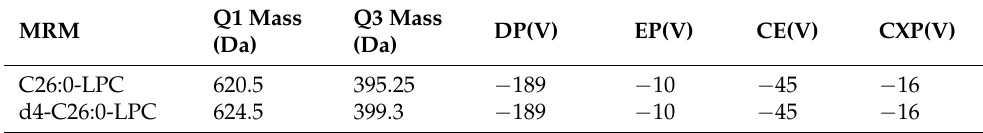
Table 1. Compound dependent parameters for MS.